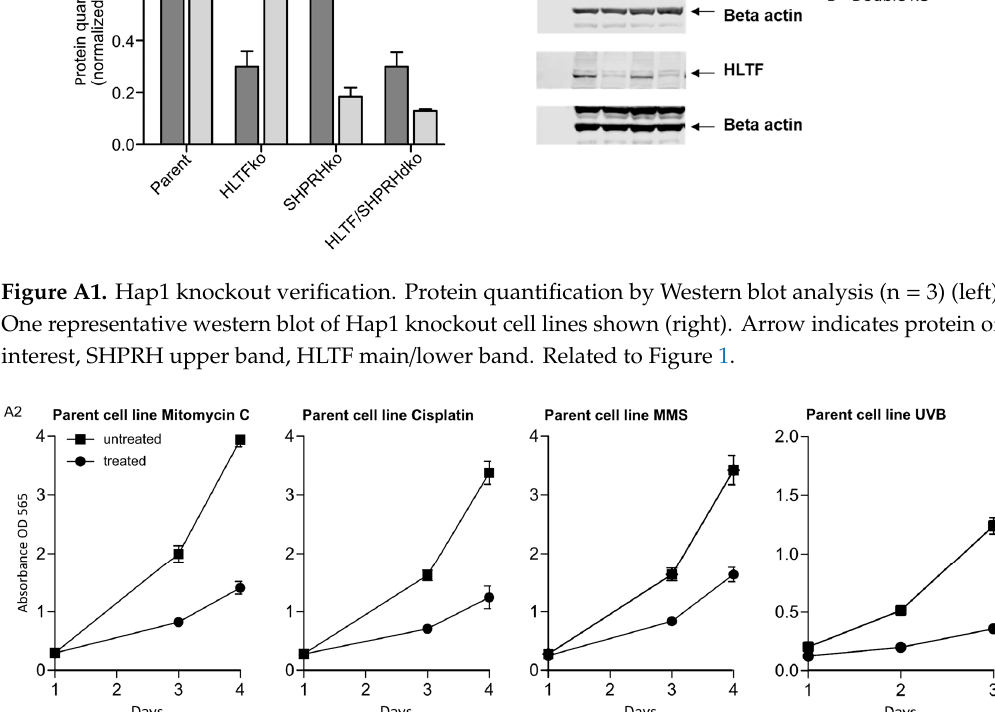
Figure A3. Western blot of Hap1 knockout cell lines before and after MMS (50μM) treatment (12 h), one representative out of the 3-5 biological experiments presented. Related to Figure 5 . Arrow indicates protein of interest.